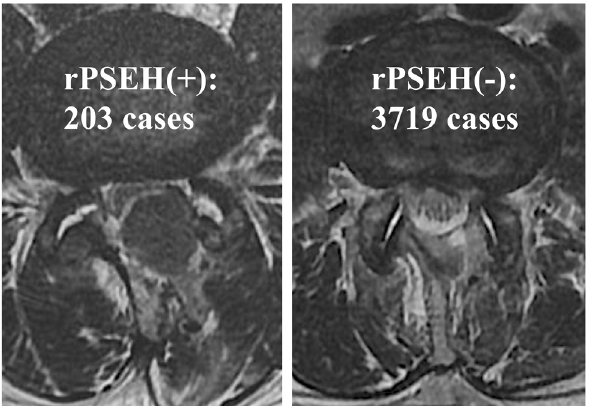
Figure 1. Postoperative magnetic resonance image of representative case with and without postoperative spinal epidural hematoma. Although the left case with rPSEH had had severe buttock pain postoperatively, the pain gradually disappeared without emergent surgical evacuation of the hematoma. rPSEH; radiographic postoperative spinal epidural hematoma .